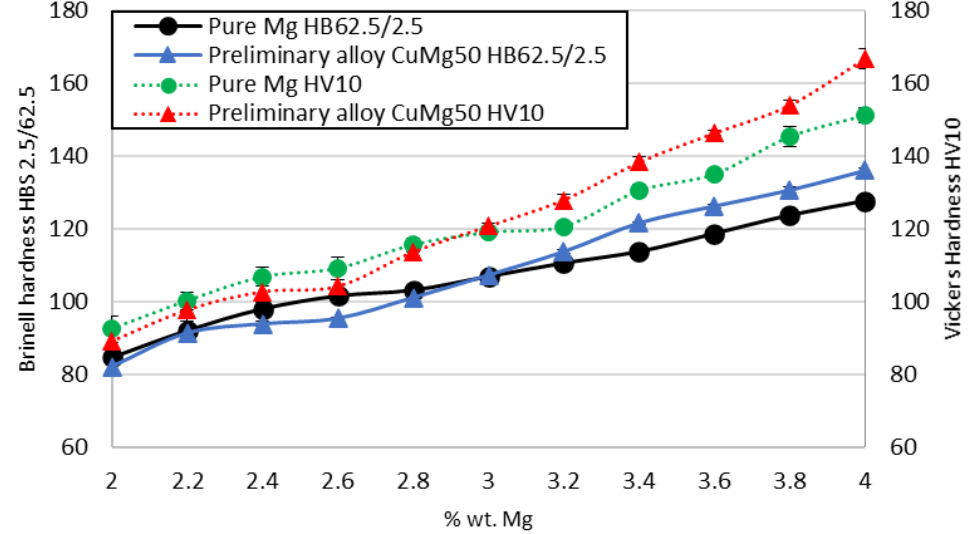
Figure 1. Average values of hardness of the tested materials; Brinell’s method marked with a full line; Vickers method marked with a dotted line; pure Mg marked with circles; preliminary alloy CuMg50 marked with triangles.